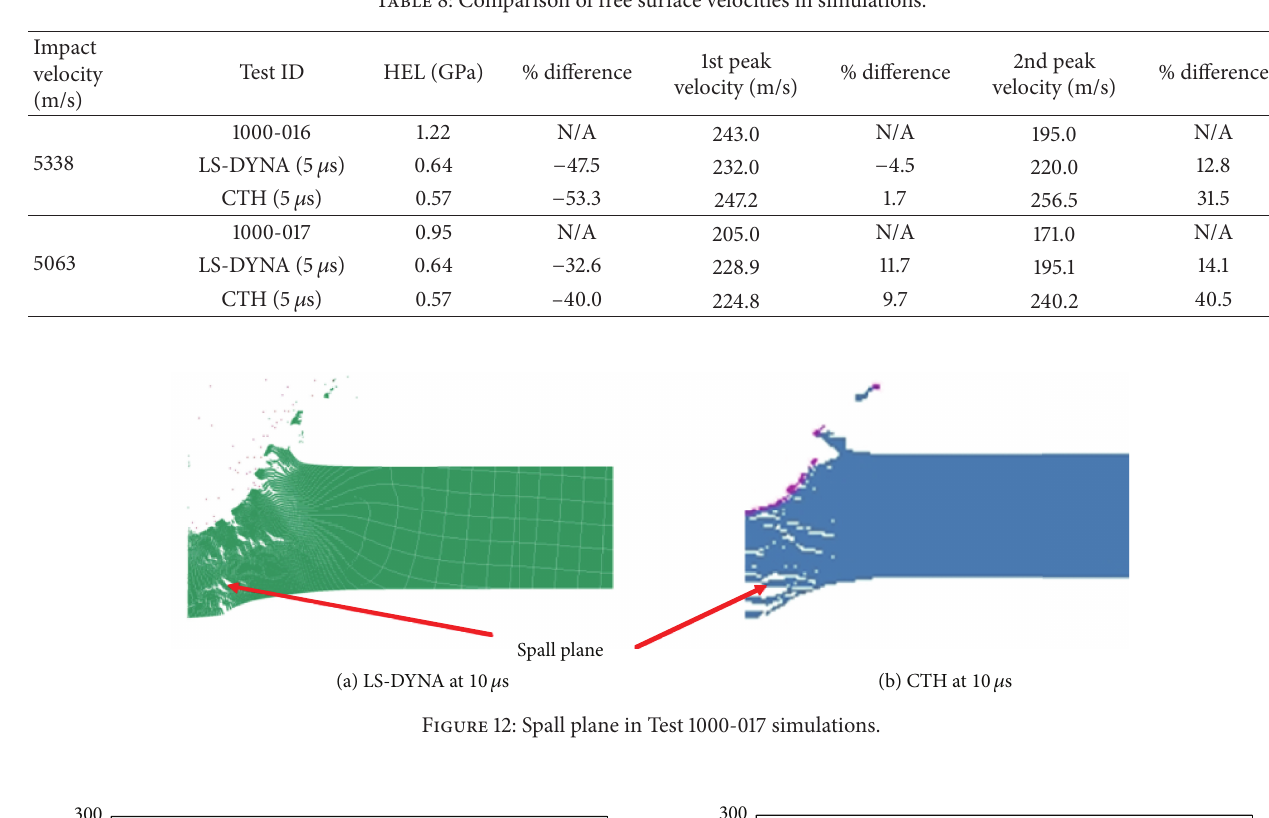
Table 8: Comparison of free surface velocities in simulations.